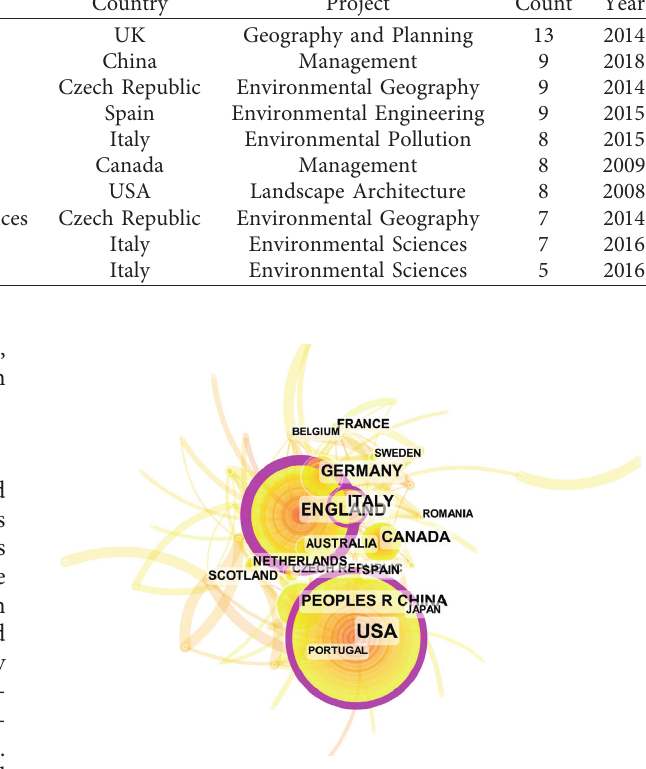
Figure 4: Brownfield research distribution in different